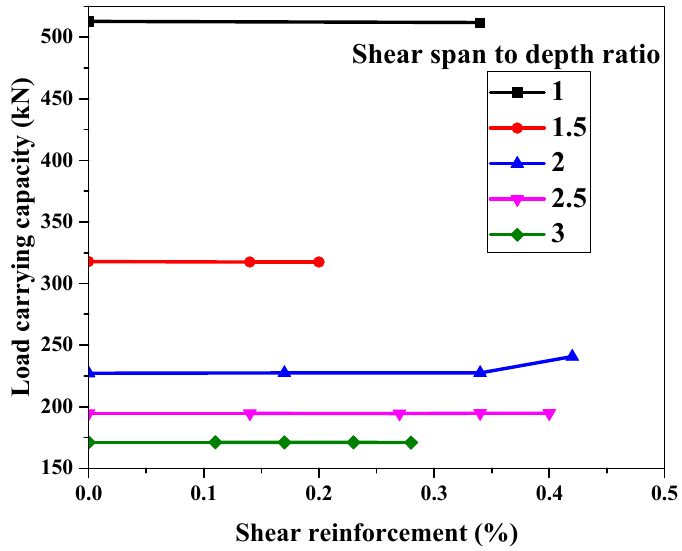
0.0 Figure 15. Effect of different reinforcement ratios on the shear capacity of ECC beams. The depth, width, span, and longitudinal reinforcement ratio of the beam were all held constant while the shear reinforcement was changed. As illustrated in Figure 15, the load-carrying capacity of ECC beams did not change appreciably when shear reinforce- ment was changed for all a/d ratios. As Zhang et al. [20] asserted, the amount of shear reinforcement for a given cross-section for all a/d ratios does not influence the load-carry- ing capacity of ECC beams. As a result, reducing shear reinforcement in ECC beams across the board looks to be gaining traction. 6.4. Crack Pattern and Failure Mode In this section, the crack pattern and the mode of failure for the beams used in the parametric study are discussed. It was noted that all beams failed with flexure-dominated shear failure. Figure 16a,b compare the plastic strain obtained from the FE analysis for S- 1 (without stirrups) and S-2 (with stirrups) beam specimens, respectively, used in the par- ametric study. It was observed that at earlier stages, the cracks propagated in the vertical direction and as increases in load occurred, the inclined shear cracks started to appear. Finally, the failure occurred due to the crushing of ECC in diagonal cracks and in the compression zone. In addition, the number of stirrups did not have any significant effect on the crack pattern and the mode of failure. Similar behavior was achieved for all the beams.